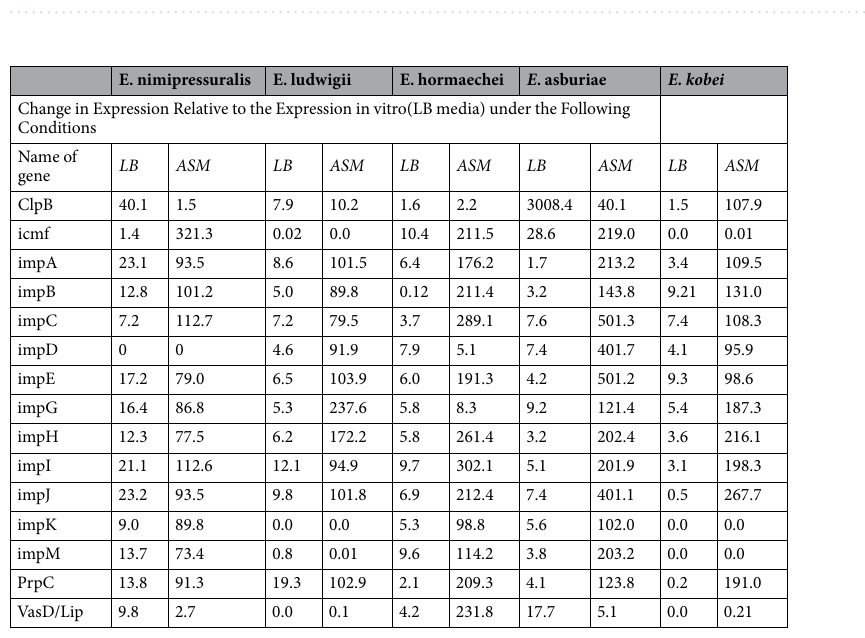
Figure 3. rpoB-based phylogenetic analysis of Enterobacter cloacae complex strains and other selected species of opportunistic bacteria.